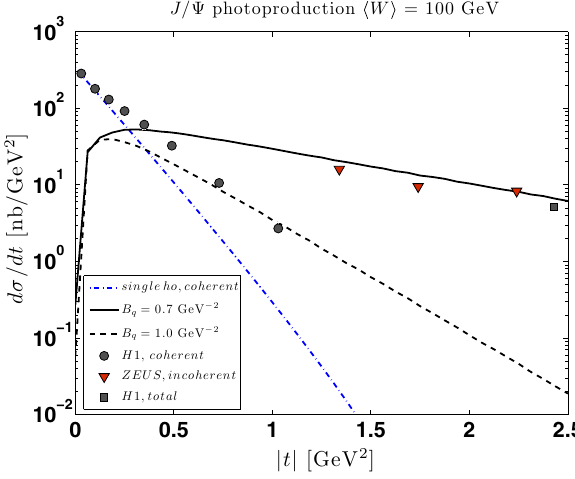
Fig. 10 Coherent and Incoherent photoproduction ( Q 2 = 0) cross section within the kinematical conditions of the HERA experiments ( x IP ≈ 9 . 6 × 10 − 4 for (cid:4) W (cid:5) = 100 GeV). The dot-dashed line represents the single-ho predictions for coherent scattering. Incoherent scattering calculations within single-ho are represented by the full and dashed lines according to the fluctuation parameter B q (see legend). Data as in Fig.